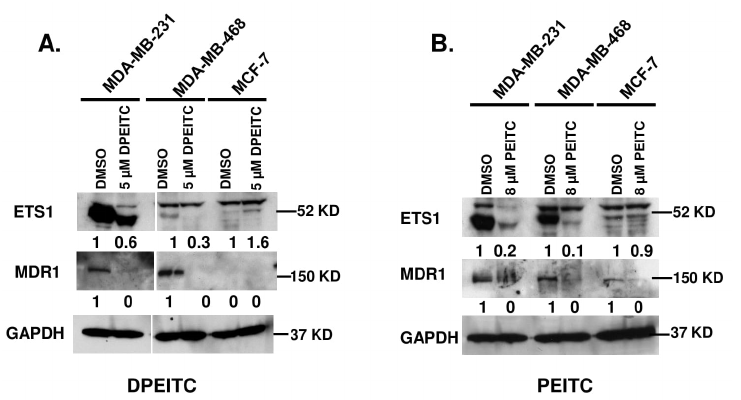
Figure 9. DPEITC reduces the expression level of ETS1 and MDR1 in mutant p53 TNBC cell lines. MCF7 (WT p53), MDA-MB-231 (p53 R280K ), and MDA-MB-468 (p53 R273H ) were treated with 5 μM DPEITC ( A ) or 8 μM PEITC ( B ) for 24 h. Control cells were treated with DMSO. The cell lysates were resolved by SDS-PAGE, probed with anti-ETS1 and anti-MDR1 antibodies, and re-probed with anti- GAPDH antibody. Experiments were performed in triplicate.